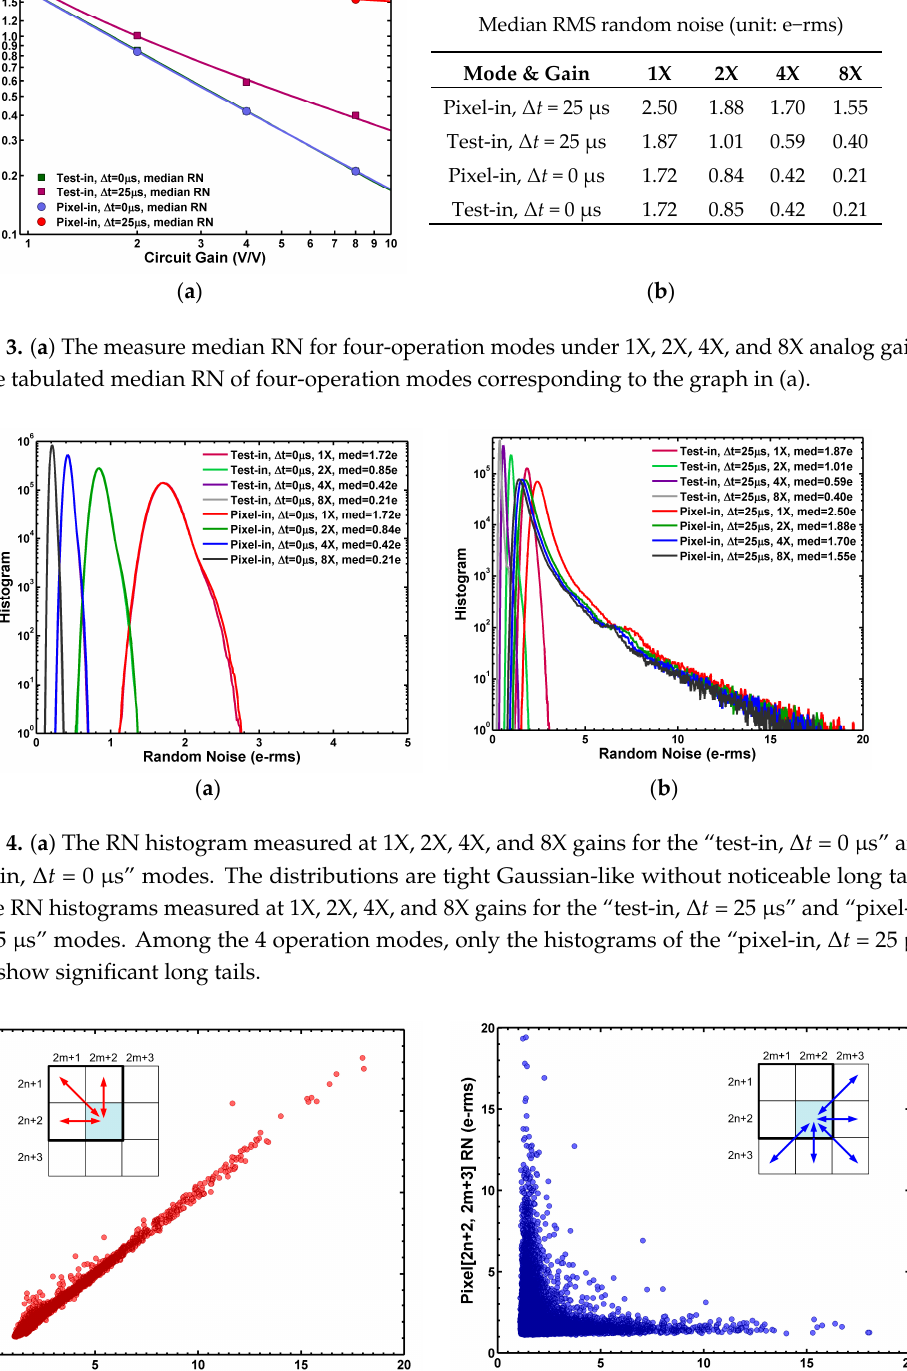
Figure 5. ( a ) For the 2 × 2, shared pixel structure, each pixel shares the same SF with three adjacent neighbors, and does not share the same SF with the other five adjacent neighbors. The random noises among pixels sharing the same SF are highly correlated; ( b ) On the contrary, the random noises among pixels not sharing the same SF are not correlated. This is indirect evidence that SF is the dominant noise source.